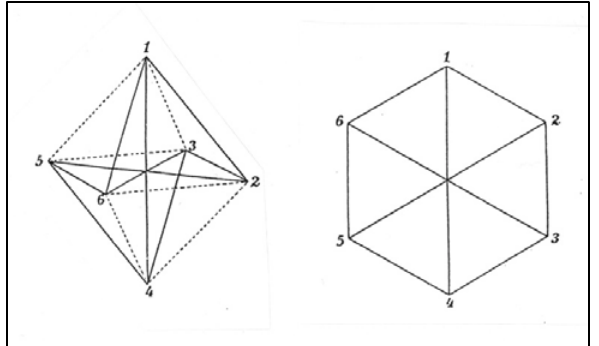
Figure 8. Based on thermochemical arguments the Danish chemist Julius Thomsen proposed in 1886 an octahedral model of benzene in which there were no double bonds. Thomsen’s structural mod- el was among those which Brühl dismissed as incompatible with refractivity data based on the Lorenz-Lorentz